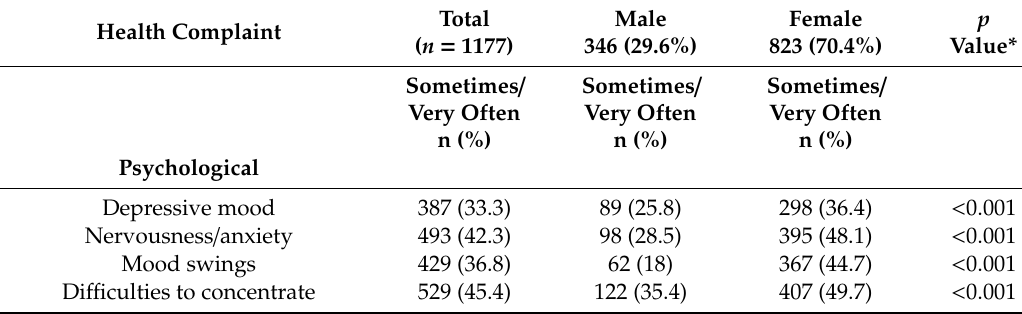
Table 3. Prevalence of self-reported health complaints during last 12 months by gender among undergraduates, University of Turku,